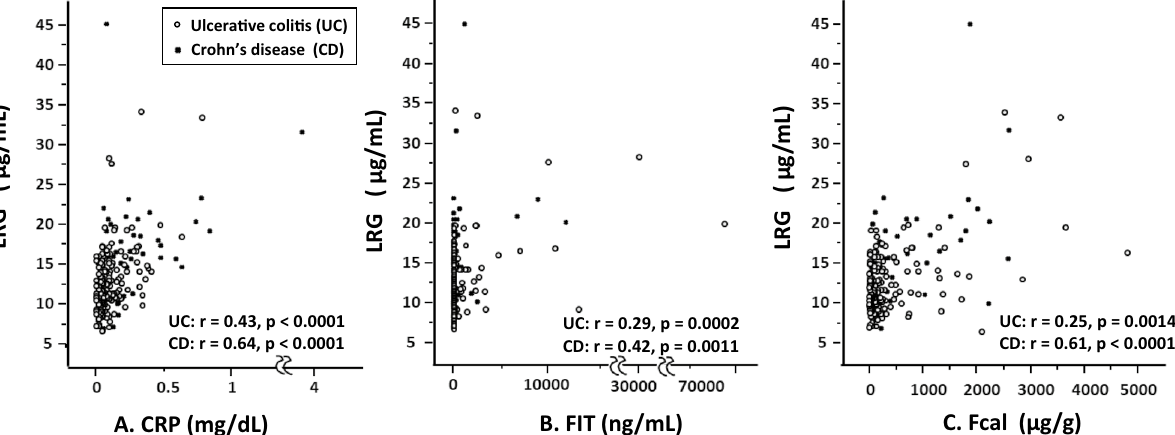
Figure 1. Correlation between LRG and the other serum/fecal biomarkers in IBD patients. ( A ) CRP, ( B ) FIT, ( C ) Fcal. LRG leucine-rich alpha-2 glycoprotein, CRP C-reactive protein, FIT fecal immunochemical test, Fcal fecal calprotectin. The round dots indicate the values of UC patients and the star dots indicate the values of CD